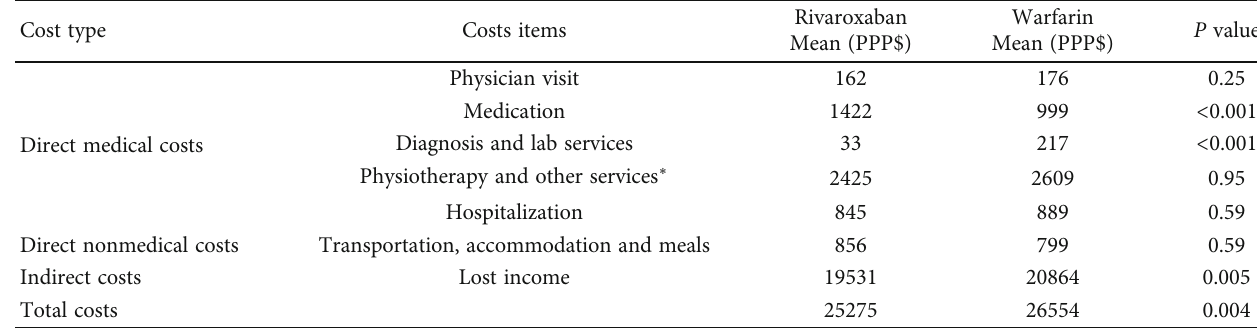
Table 1: Direct and indirect costs of patients with atrial fi brillation treated with rivaroxaban and warfarin in 2019.